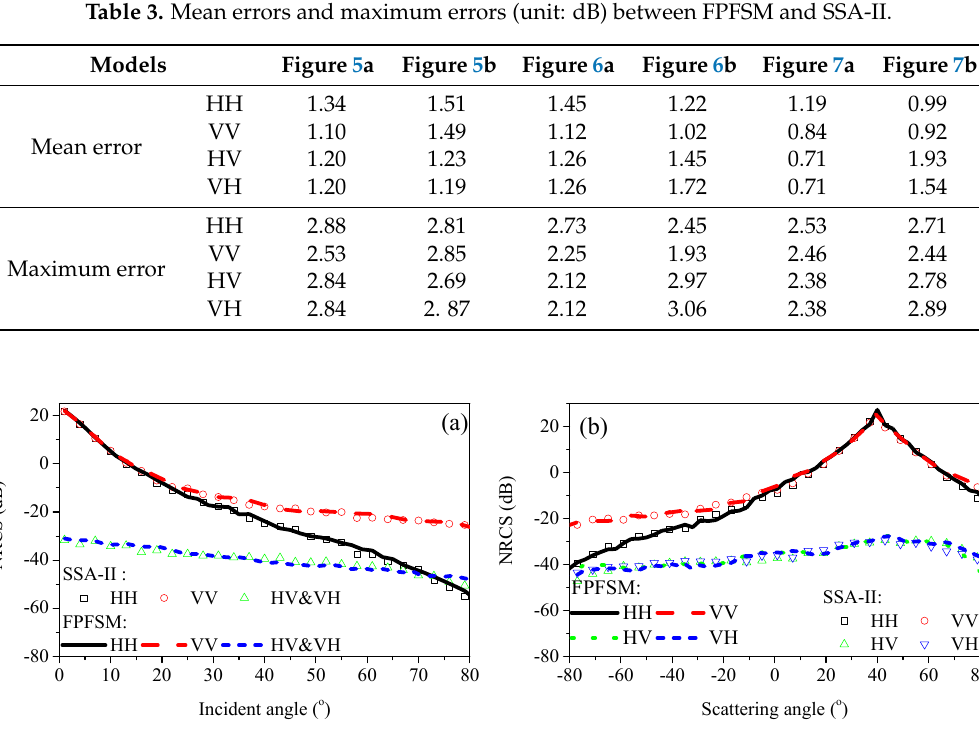
Table 1. Comparison of the time consumption (unit: seconds) between FPFSM and SSA-II. Models Table 2. Comparison of the peak memory consumption (unit: Mb) between FPFSM and SSA-II. Models